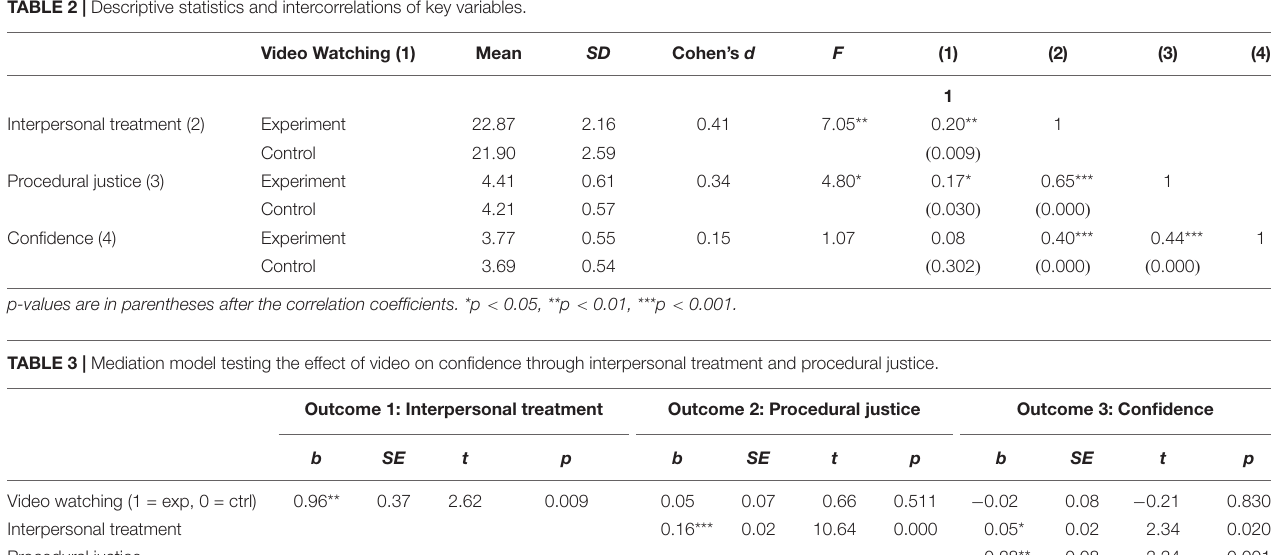
TABLE 2 | Descriptive statistics and intercorrelations of key variables.